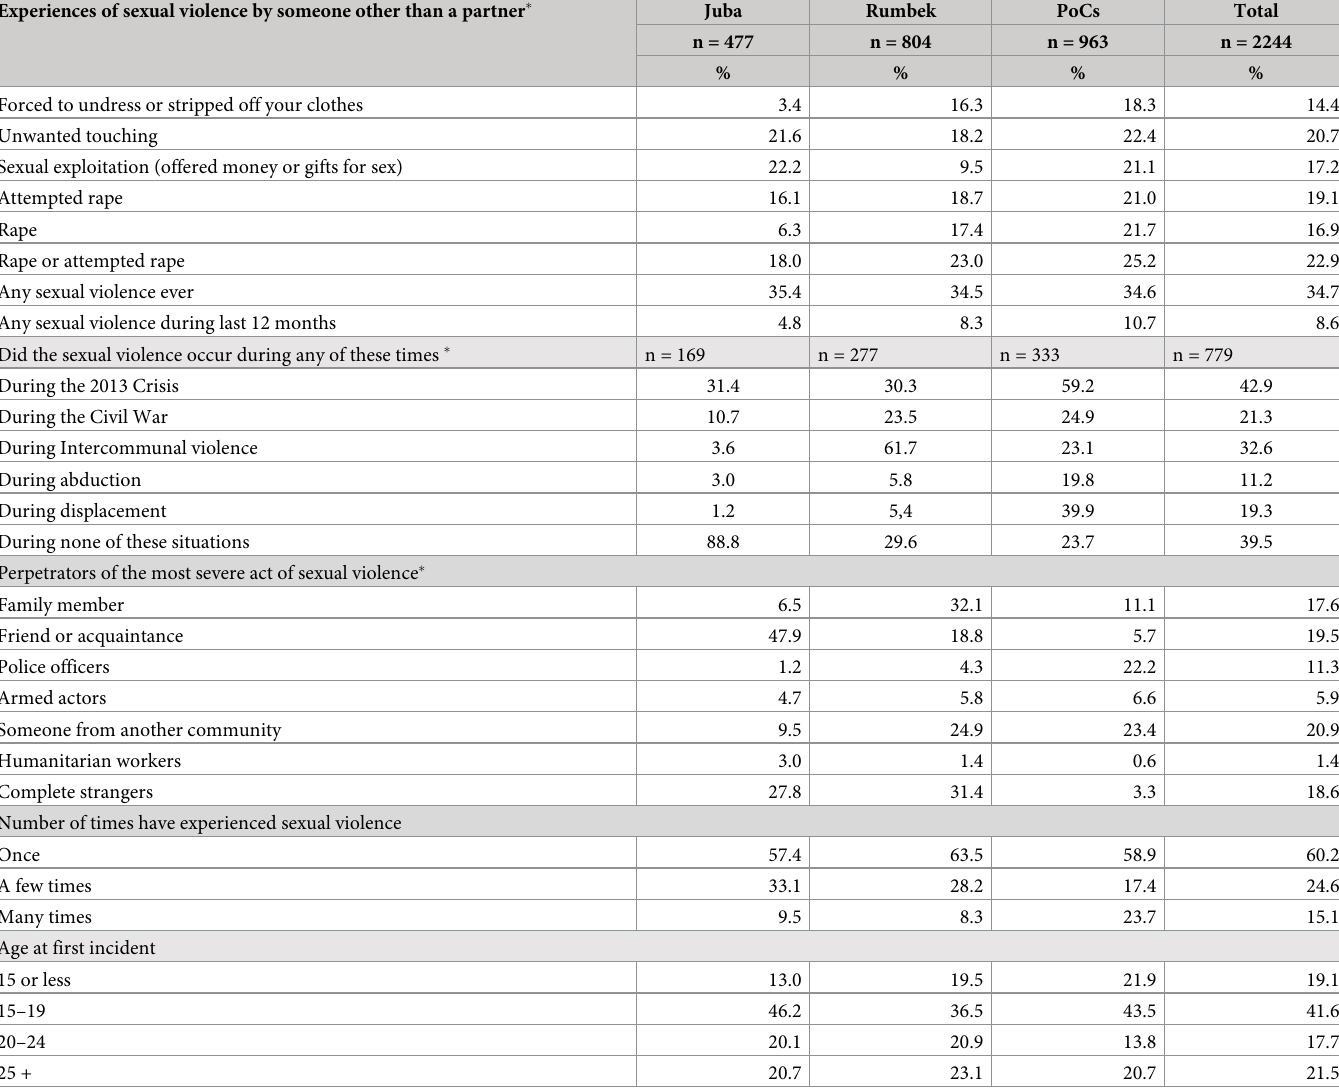
Table 4. Sexual violence by non-partners and experiences of